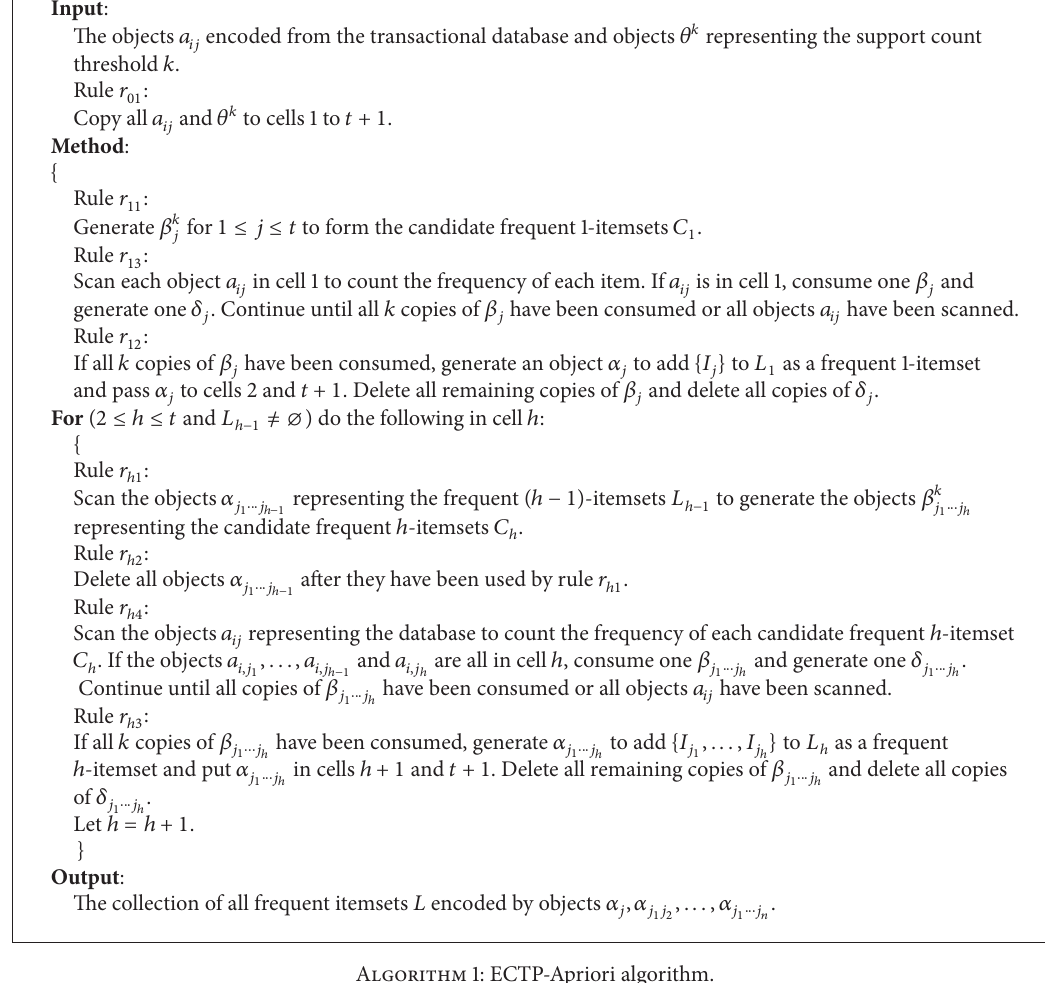
Algorithm 1: ECTP-Apriori algorithm.